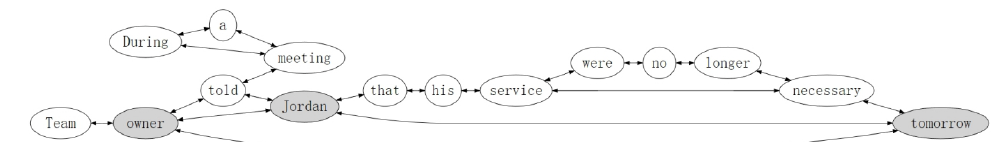
Figure 4. Self-constructed dependency